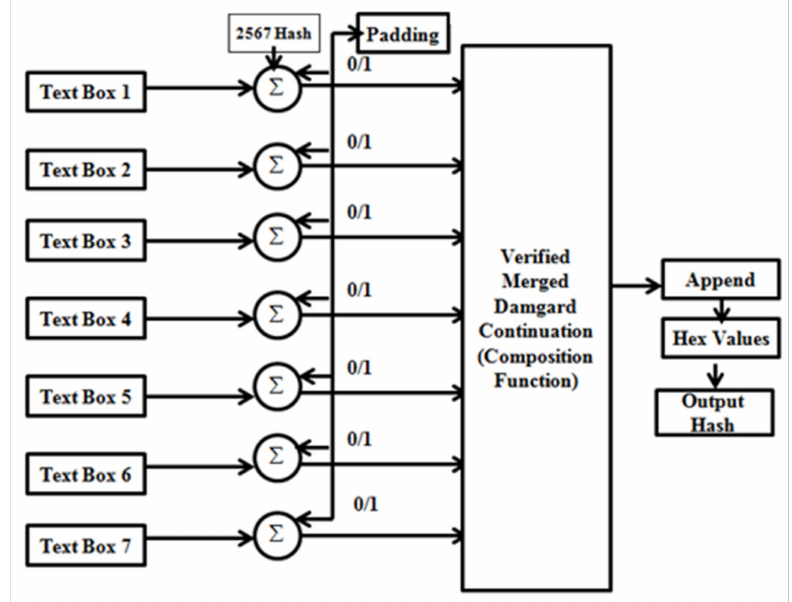
Figure 8. Block diagram of the proposed encryption module.